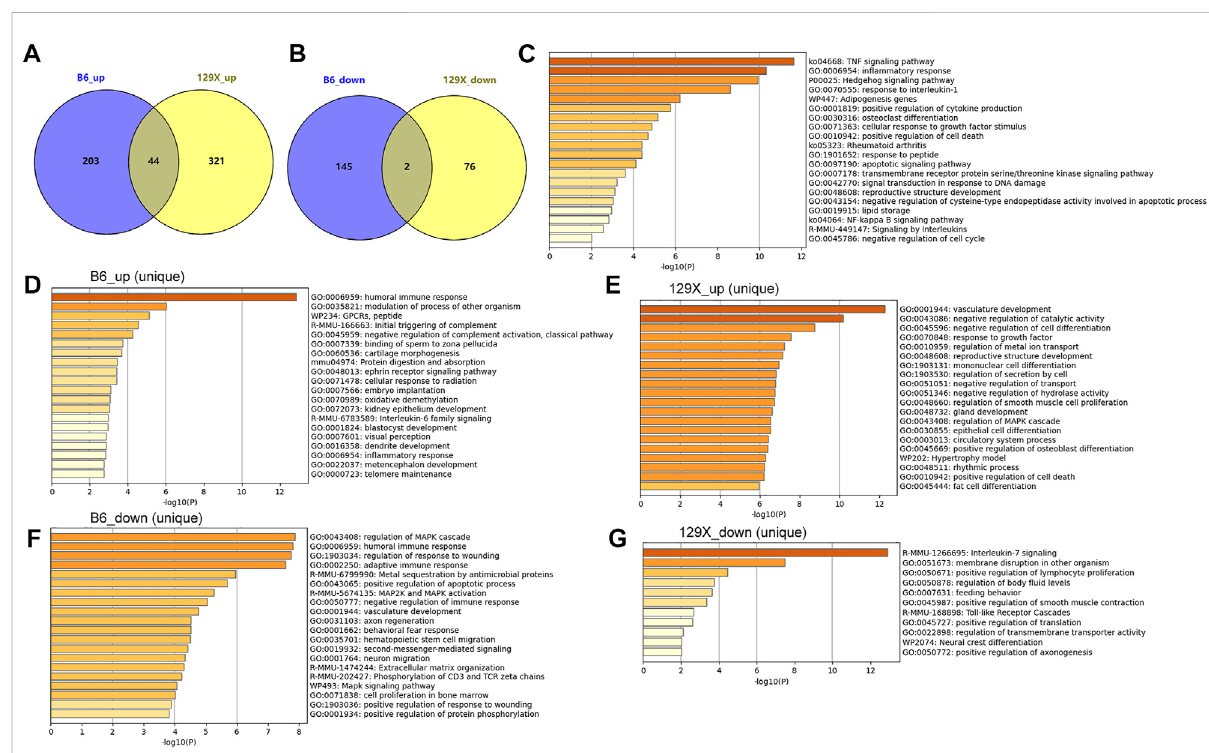
FIGURE 7 Dysregulatedcochleargenesinmousemodelsduetonoiseexposureandtheirfunctionalenrichment. (A) Genenumbersupregulateduniquely or consistently in the two kinds of mice due to noise exposure. (B) Gene numbers downregulated uniquely or consistently in the two kinds of mice due to noise exposure. (C) Pathways signi fi cantly associated with common upregulated genes in the susceptible B6 and resistant 129X mice due to noise exposure. (D,E) Pathways signi fi cantly associated with uniquely upregulated genes due to noise exposure in the susceptible B6 mice and resistant 129X mice, respectively. (F,G) Pathways signi fi cantly associated with uniquely downregulated genes due to noise exposure in the susceptible B6 mice and resistant 129X mice,